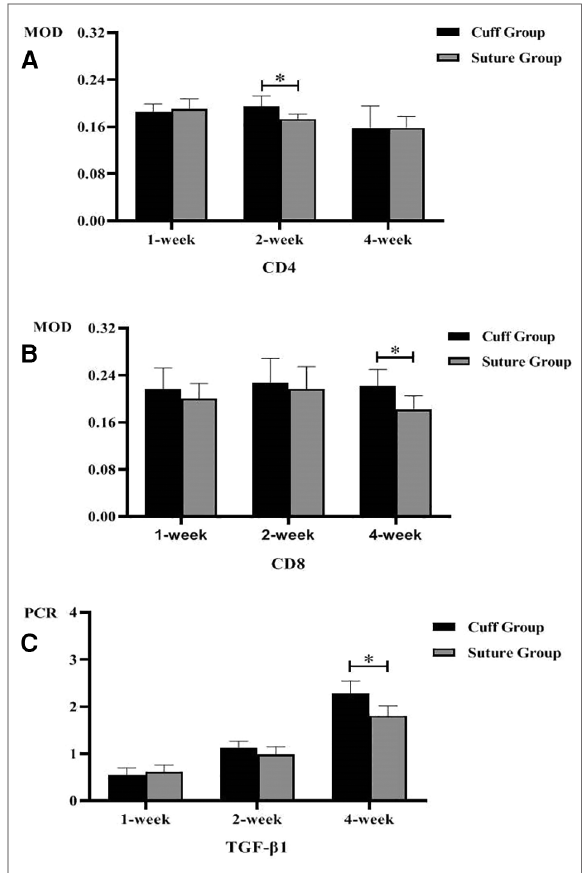
FIGURE 8 Postoperative MOD value and PCR quanti fi cation of replaced vessels in two vein replacement models (* indicates statistically signi fi cant difference between the two groups). ( A ) MOD values of CD4 immunohistochemical staining at different time points in the two models. ( B ) MOD values of CD8 immunohistochemical staining at different time points in the two models. ( C ) PCR quanti fi cation of TGF- β 1 in replaced vessels at different time points in the two models. Error bars represent standard deviation of the